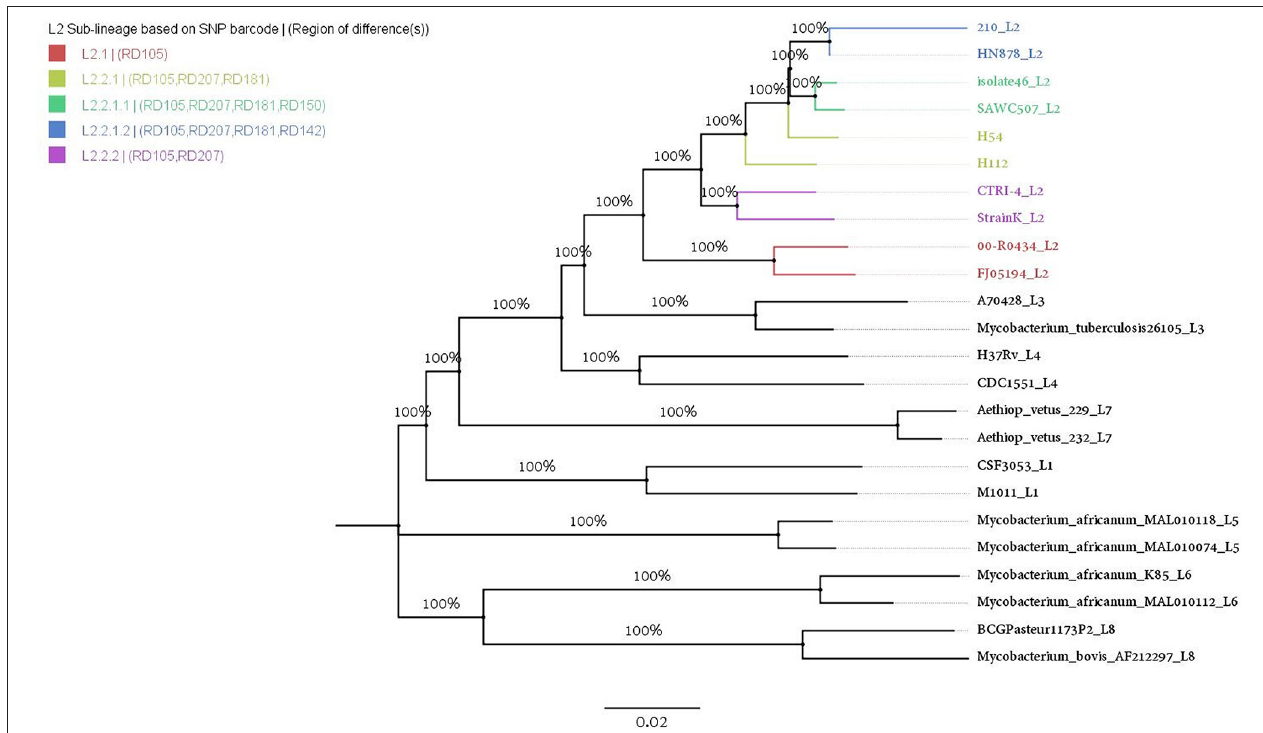
FIGURE 3 | Phylogenetic placement of H112 and H54. Assignment of phylogenetic lineage to H112 and H54 is illustrated using ML-tree with representative strains from all eight major lineages (L1–L8) of M. tuberculosis complex (MTBC) and L2 sub-lineages. Branch labels indicate bootstrap values in percentage from 100